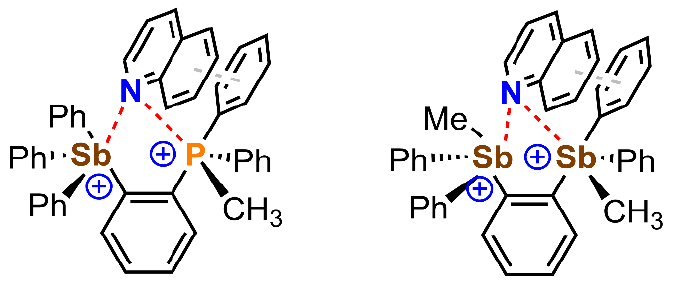
Figure 11. Schematic representation of the plausible transition state stabilization through bifurcated PnB and π – π stacking interactions involving compounds 22 and 23 . PnB and π – π stacking interactions involving compounds 22 and 23